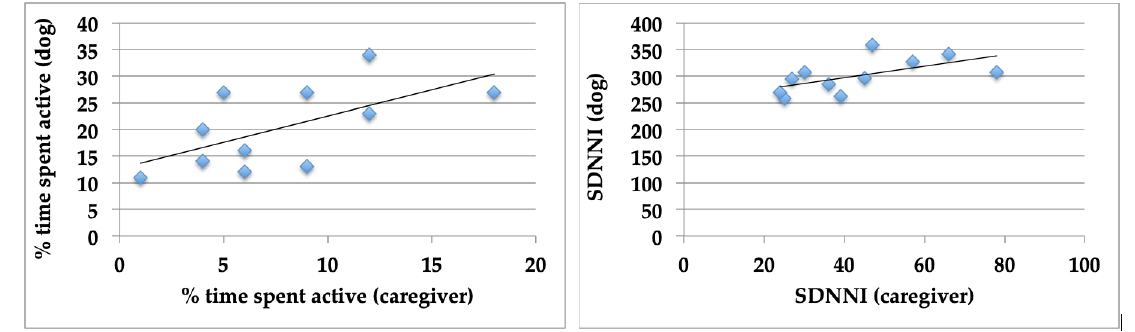
Figure 1. Relationship between activity ( left panel ) and HRV (SDNN index) ( right panel ) in the human–dog dyads over a 24-hr period.